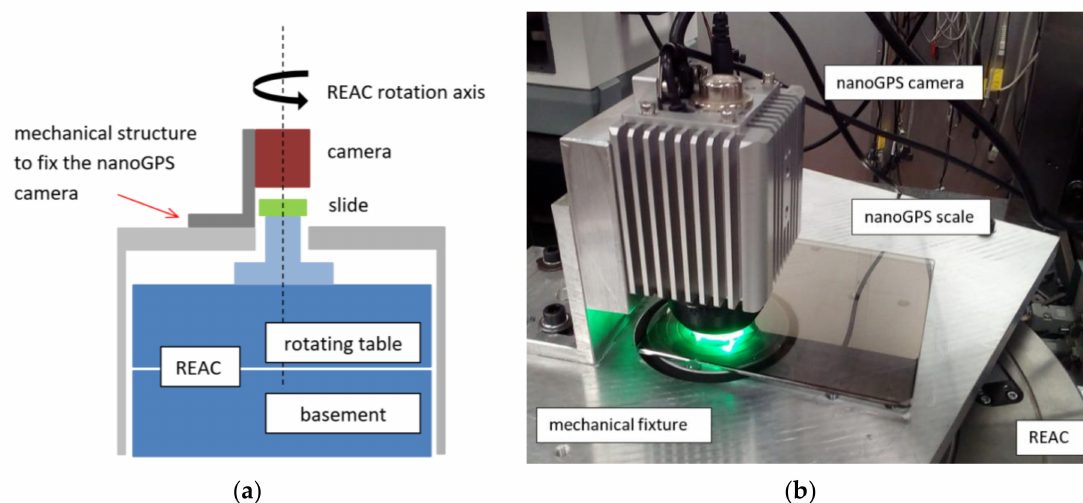
Figure 2. ( a ) Scheme and ( b ) picture of experiment setup for comparison between nanoGPS OxyO ®